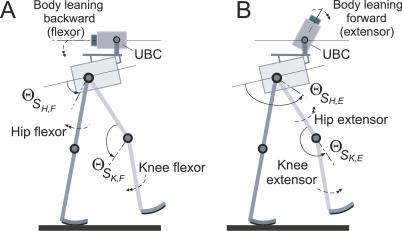
Control Parameters for the Joint Angles(A) Flexor angles. (B) Extensor angles. ΘSE (ΘSF) indicates the threshold of the sensor neuron for extensor (flexor). H, hip; K, knee.